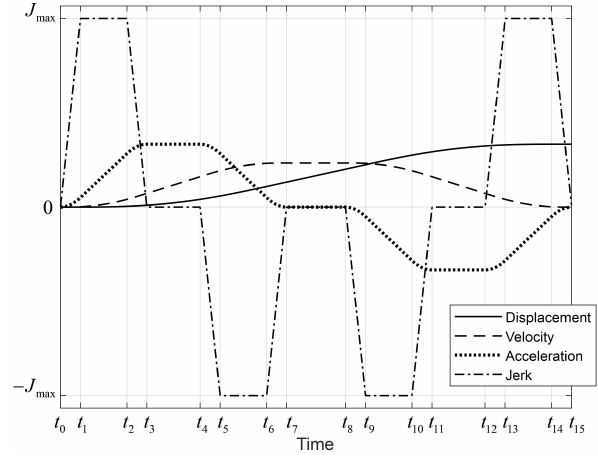
Figure 3. Kinematic trajectory of the fourth-order S-curve. Table 1. The expression of the motion profiles with different time intervals and curve